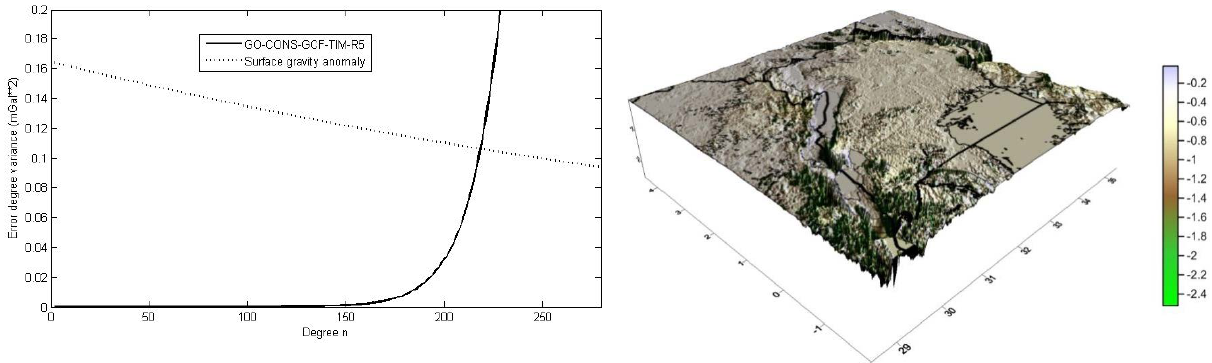
Figure 2: Error degree variances of GO-CONS-GCF-TIM-R5 and sur- face gravity anomaly